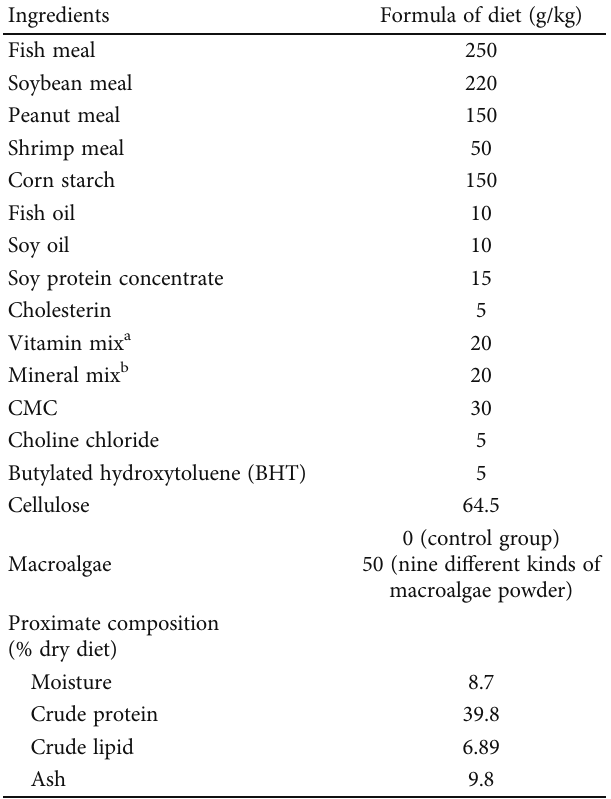
Table 1: Dietary formulation and concentration of di ff erent